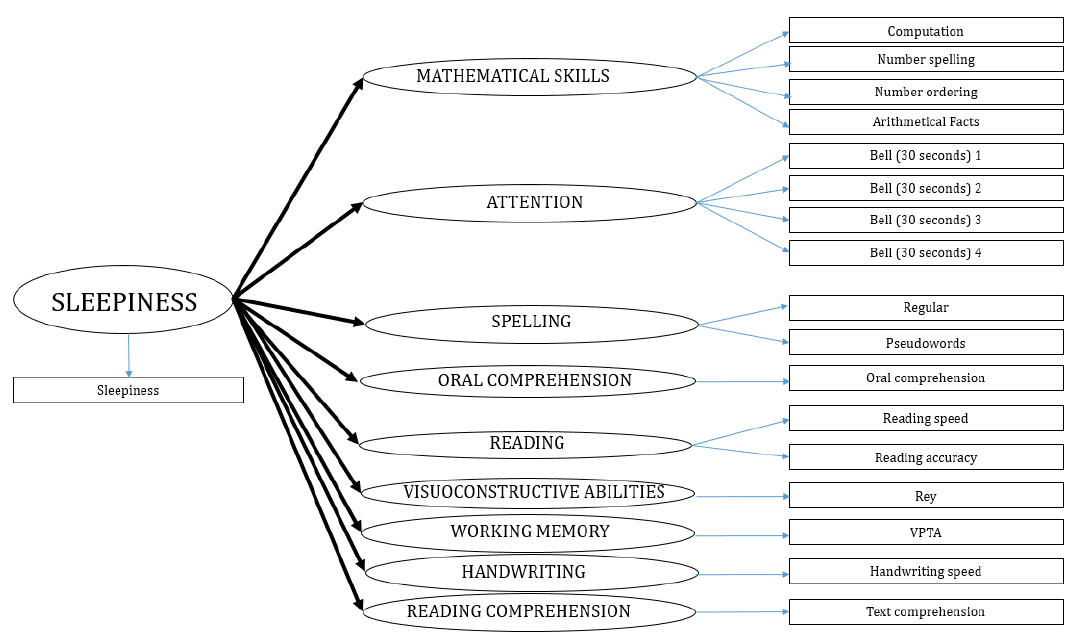
Figure 2. The inner and outer model.